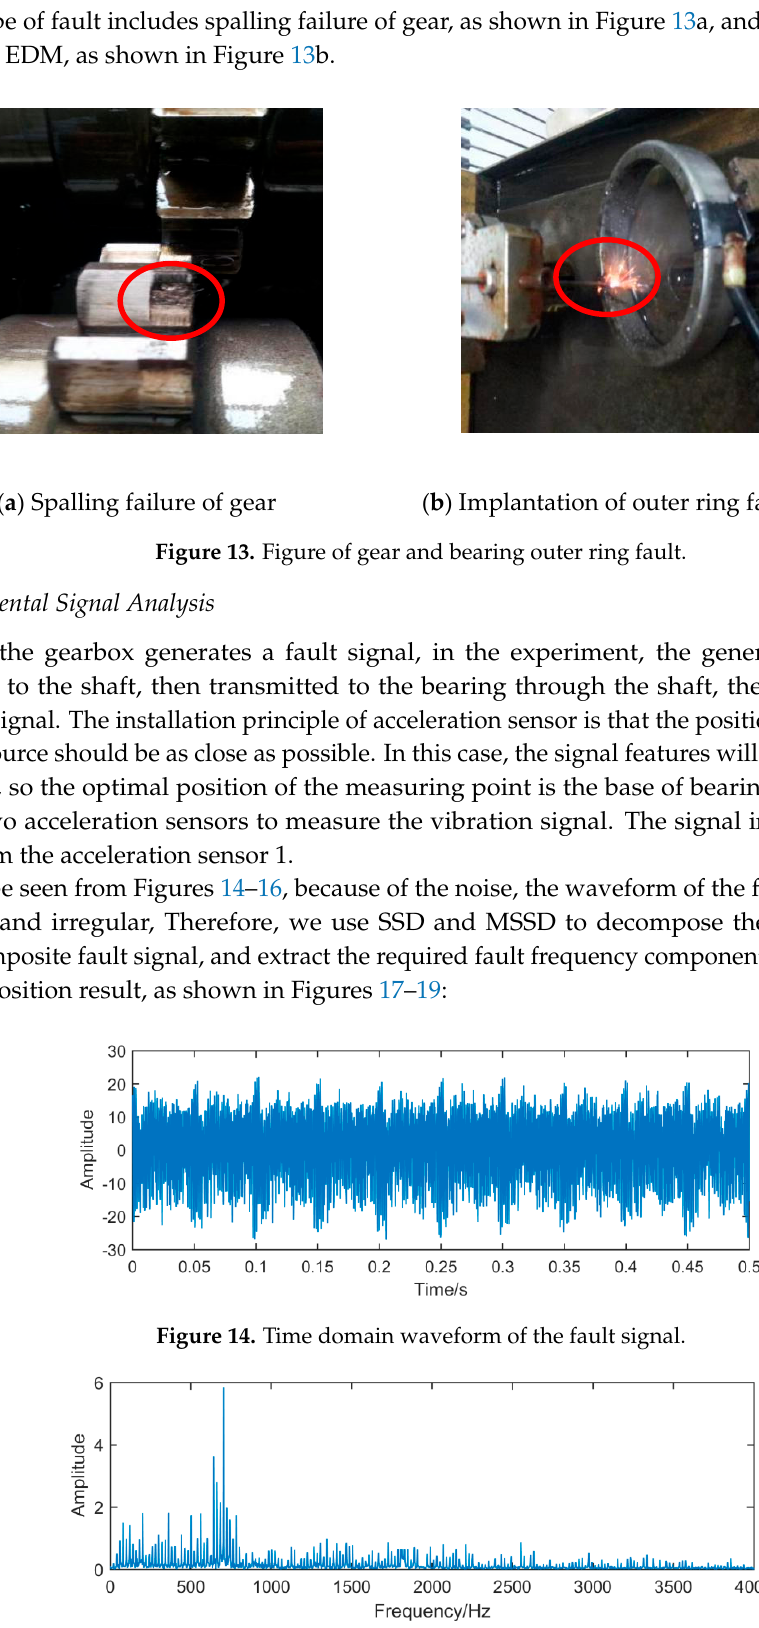
Figure 16. Amplified spectrum of Figure 15. Figure 17. The spectrum of IMFs after SSD decomposition and its corresponding spectrum.